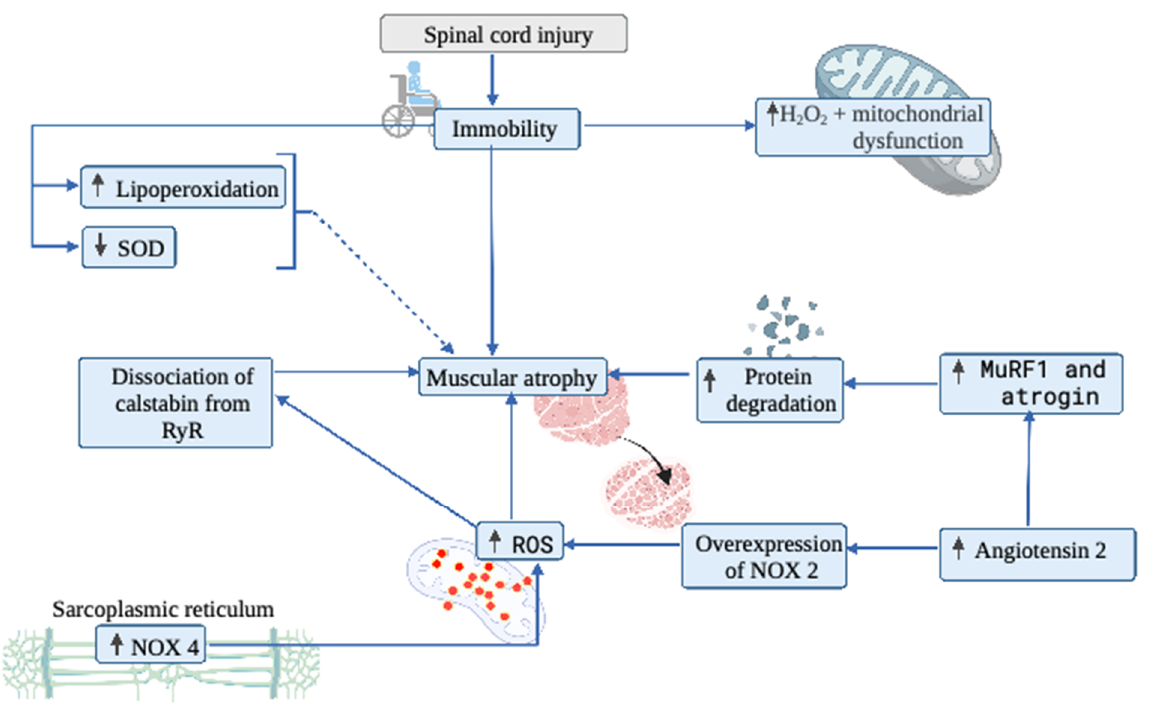
Figure 3. Overview of the role of inflammation and oxidative stress on muscle tissue in spinal cord injured patients. SOD: Superoxide dismutase; NOX4: NADPH oxidase 4; NOX2: NADPH oxidase 2; ROS: Reactive oxygen species; MuRF1: Muscle RING-finger protein-1.